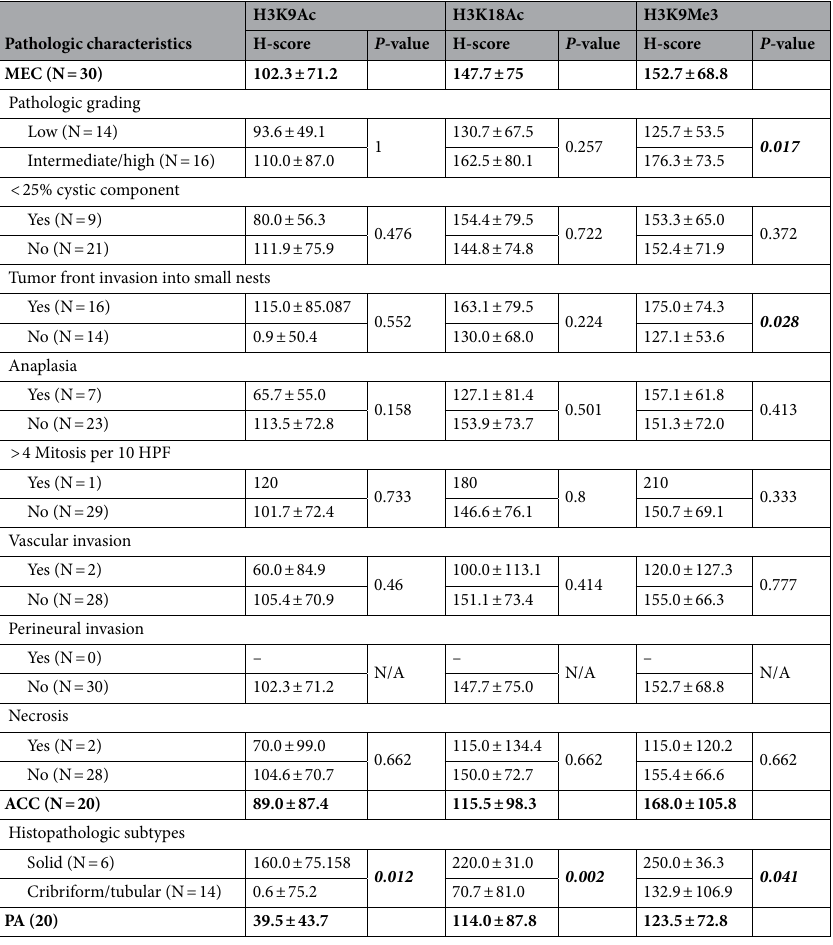
Table 2. The association between 3 types of histone H3 modifications and pathologic characteristics of MEC and ACC. Significant values are in [bolditalics].